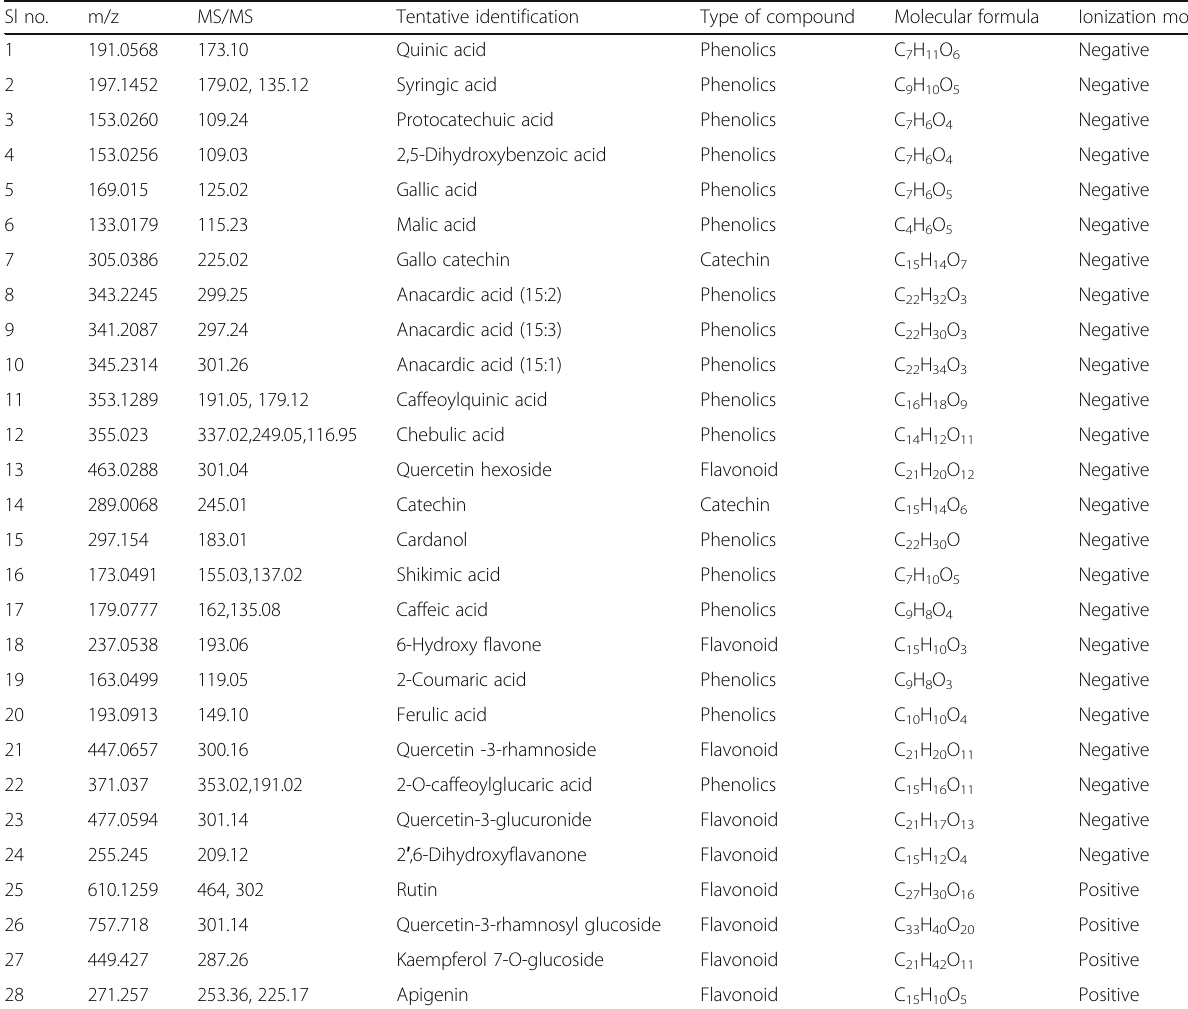
Table 1 ESI-LC-MS/MS analysis of